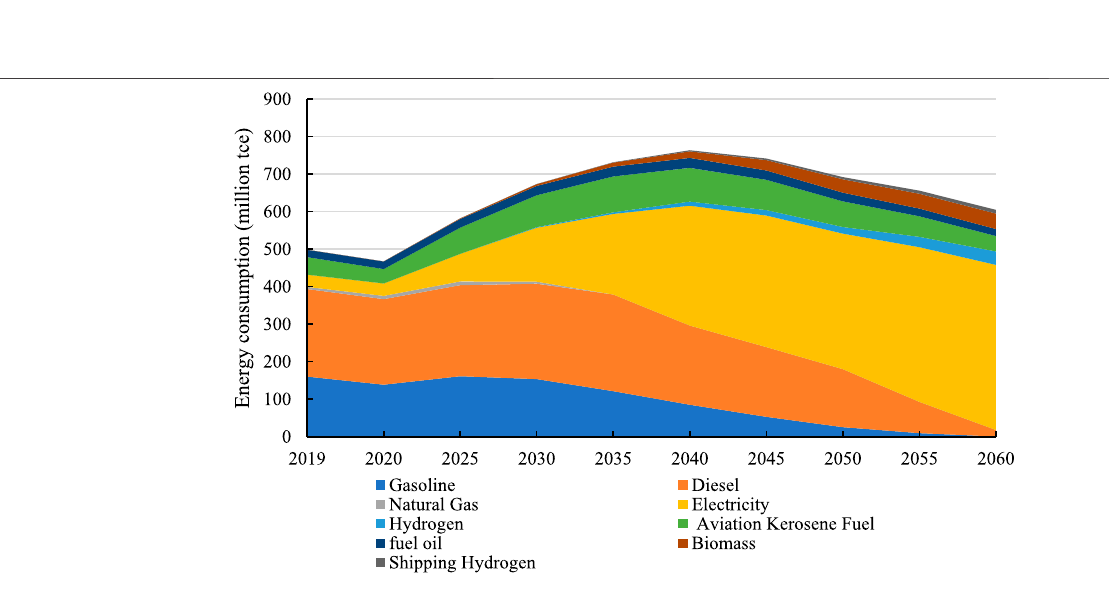
FIGURE 11 | Different fuel consumption trends under the dual carbon policy